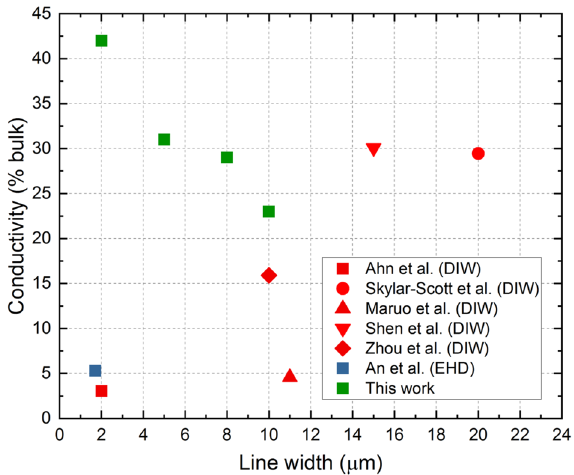
Figure 1. Conductivity of silver lines in terms of the percent of bulk conductivity of silver, obtained for lines with the width below 20 µm, fabricated using various additive manufacturing techniques: Electrohydrodynamic (EHD) printing, Direct Ink Writing (DIW), and Ultra-Precise Deposition (this work). Reference data were taken from 11–13,21–23